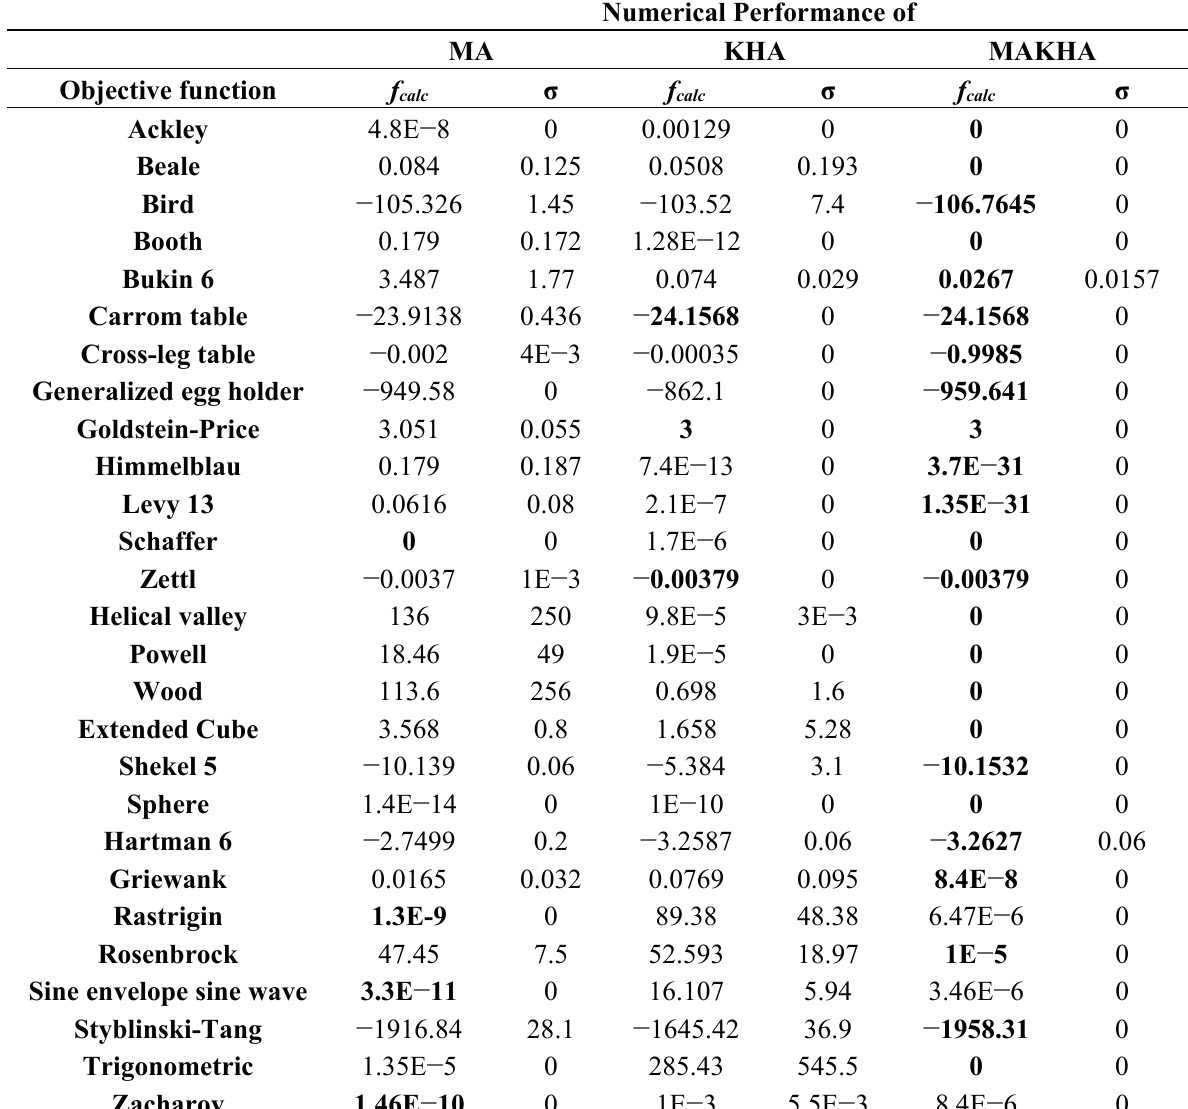
Table 4. Values of the mean minima ( f calc ) and standard deviations ( σ ) obtained by the MAKHA, MA and KHA algorithms for the benchmark problems used in this study.